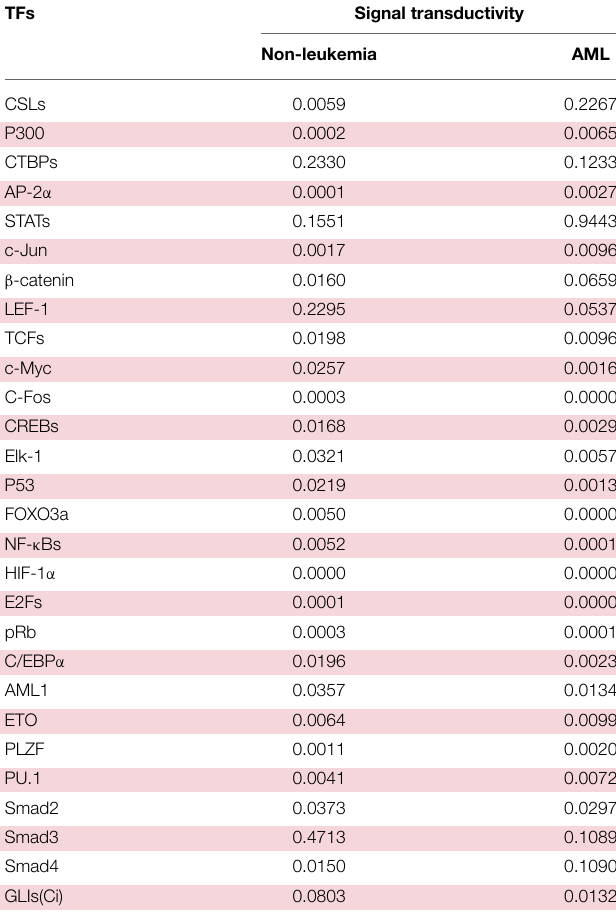
TABLE 1 | The signal transductivities of signal transduction pathways in Figure 2 from extracellular signals to 28 TFs in non-leukemia normal cells and acute myeloid leukemia (AML) cancer